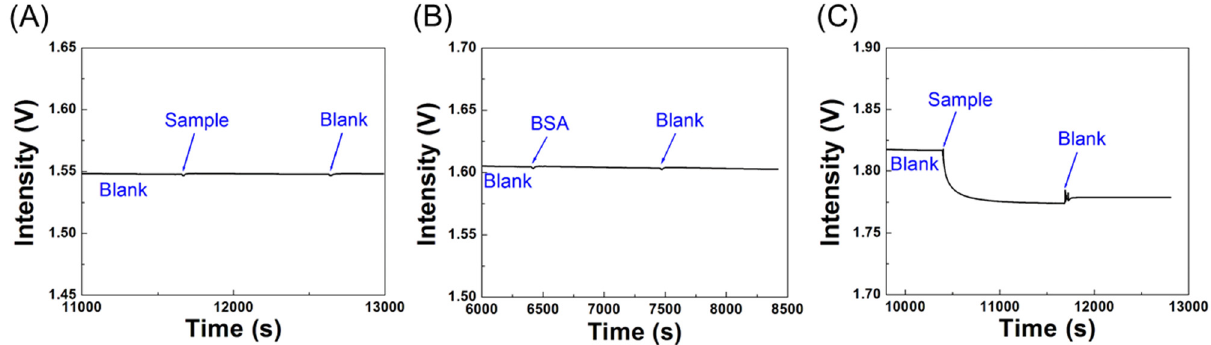
Figure 8. Real-time sensorgrams of NP-A48-functionalized sensor chips in response to ( A ) a solution of S-protein (1 μ g/mL), ( B ) a solution of BSA (1 μ g/mL), and ( C ) a solution of the N-protein (1 μ g/mL).